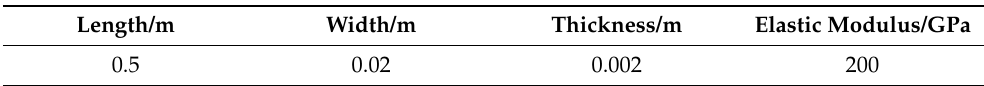
Figure 12. Test-state diagram. The specific parameters of the simulated SDOF system are shown in Table 2, below. Table 2. The parameters of the cantilever beam.